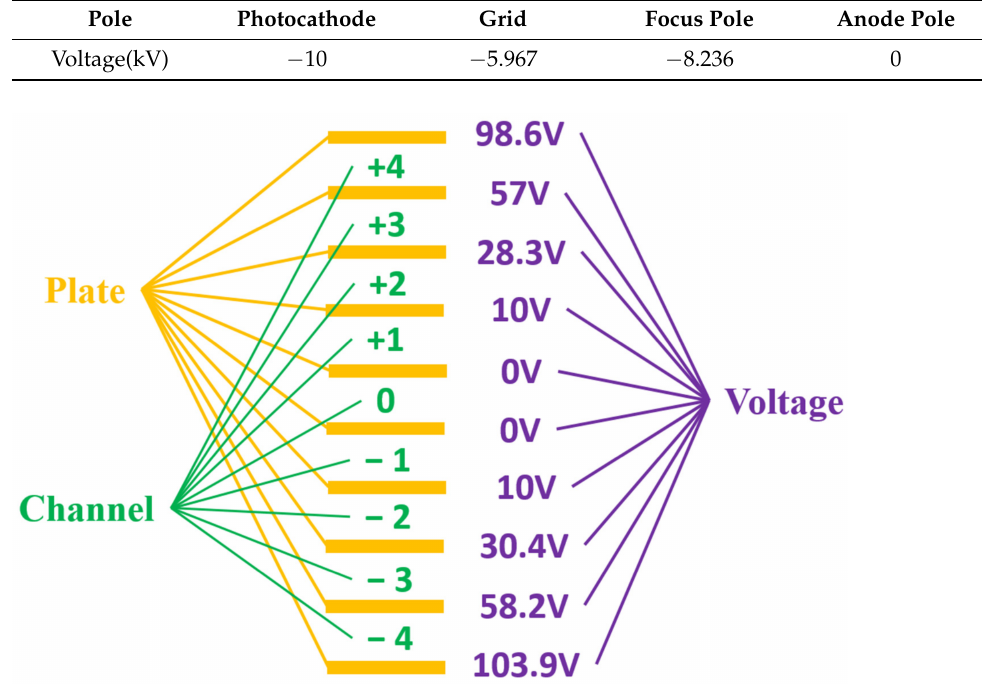
Figure 7. On board voltage of each channel array on the separator: the yellow part refers to the electrode corresponding to each channel of the separator, the green part refers to each channel in the separator, and the purple part refers to the DC voltage applied on each channel